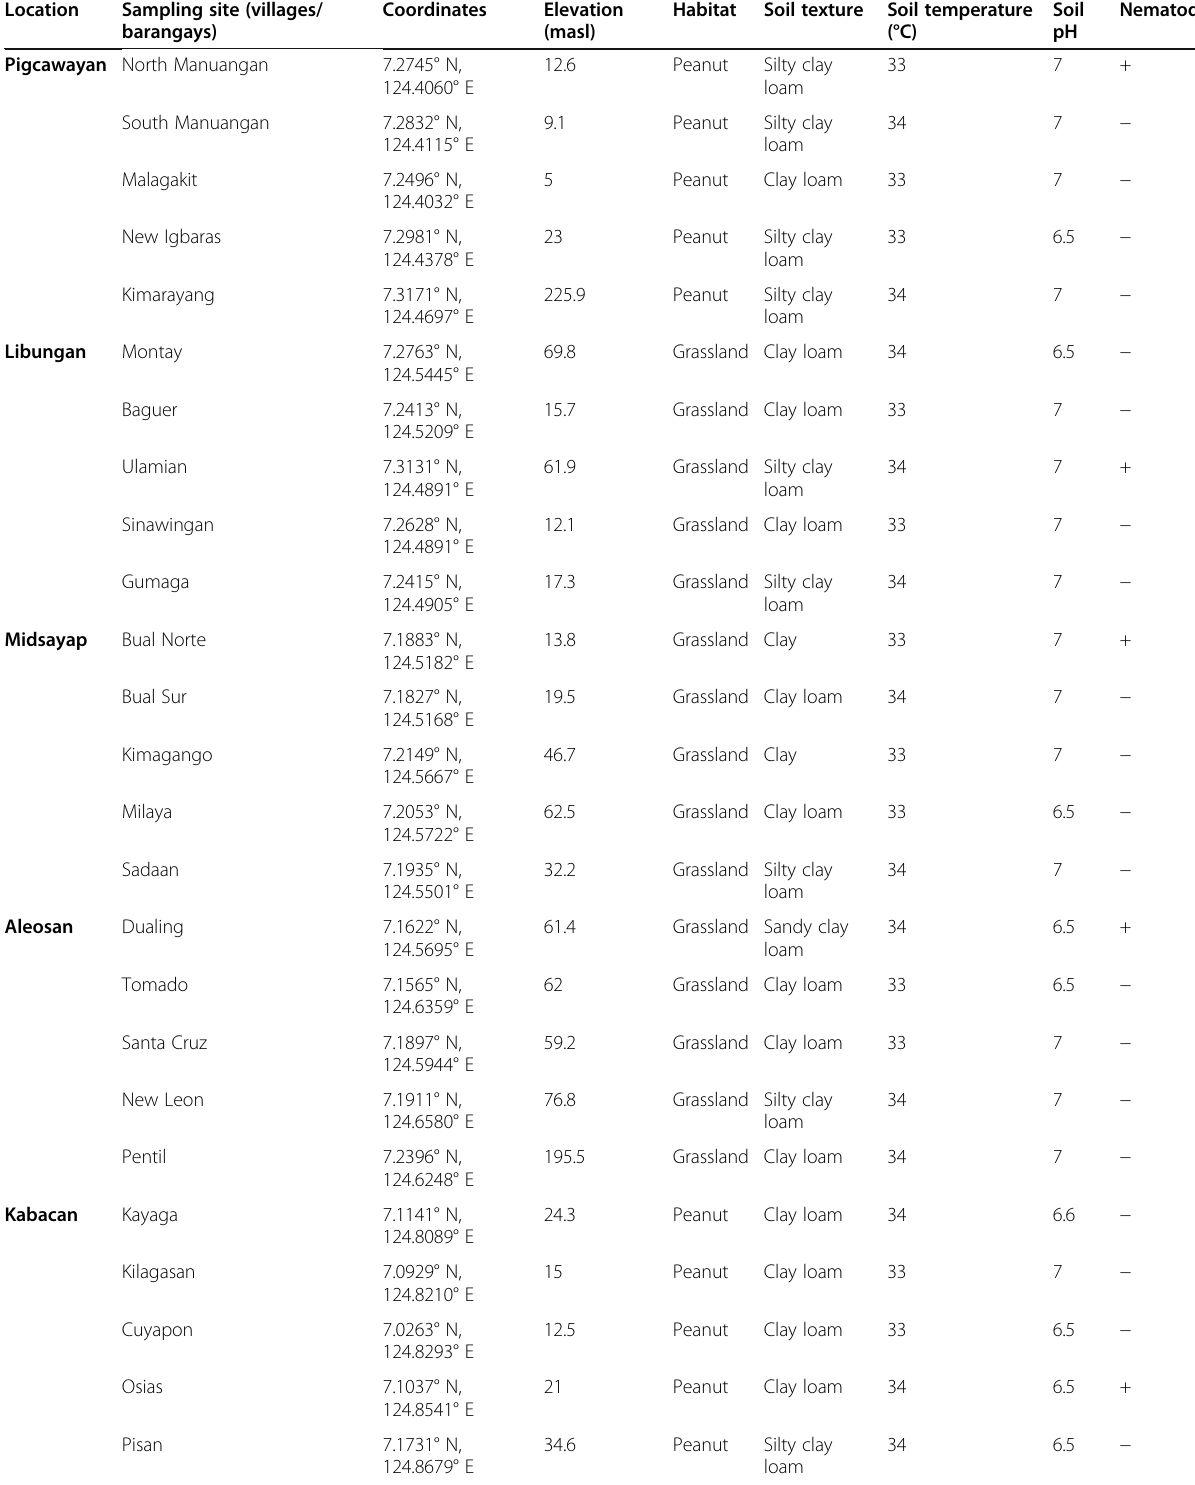
Table 1 Occurrence of entomopathogenic and facultative necromenic nematodes in the province of Cotabato, Philippines, with different soil parameters Location Sampling site (villages/